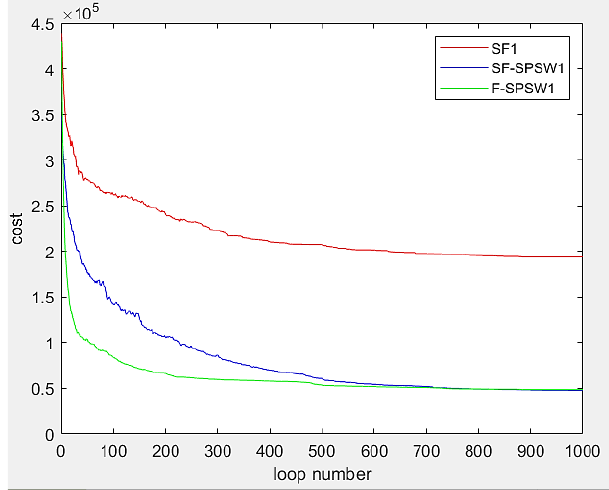
Figure 16. Convergence histories.